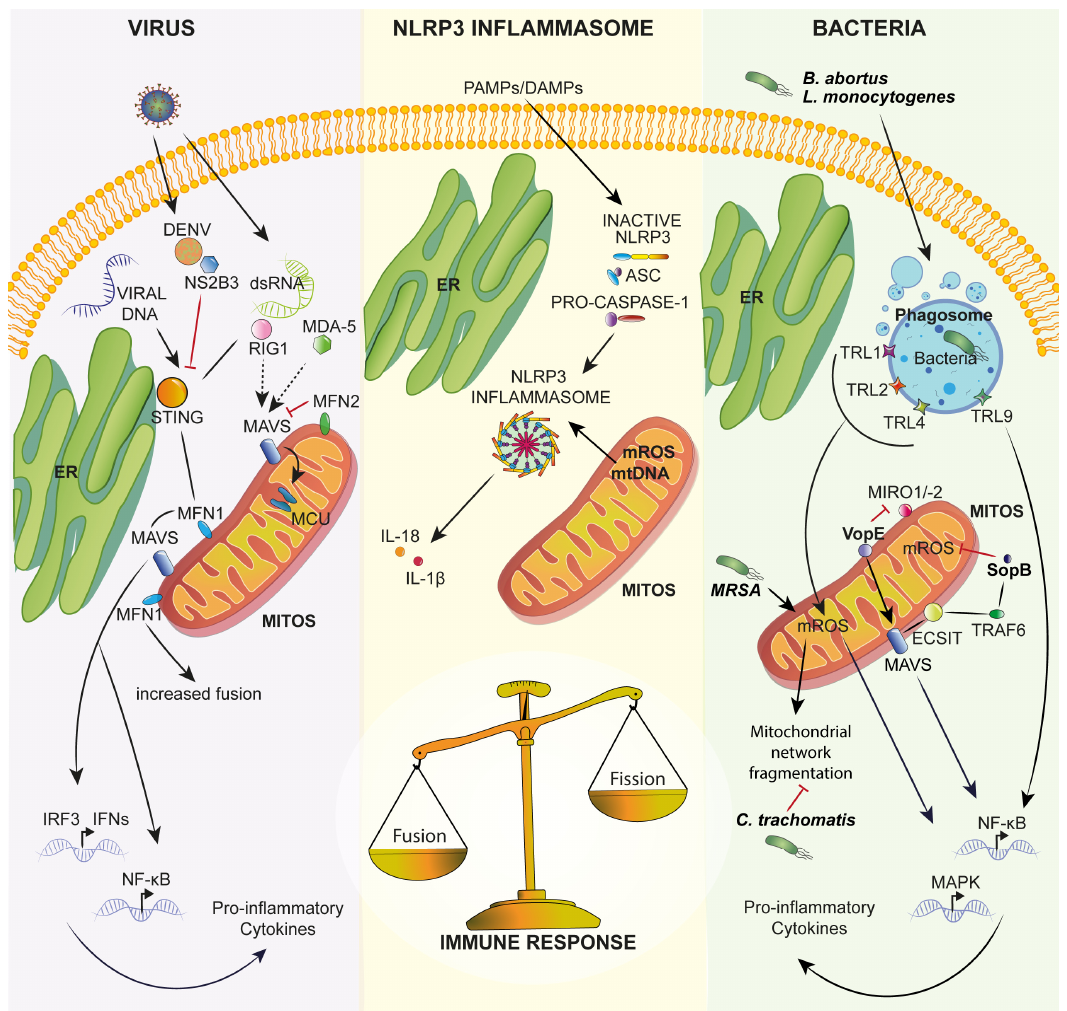
Figure 1. Schematic representation of the role of mitochondria in innate immunity. Viral infection, exposure to PAMPs/DAMPs or exposure to bacteria can activate the immune response, altering mitochondrial dynamics and functions. Upon viral infection, MAVS plays a key role in activation of the innate immune response, activating NF-kB and IRF-3 (interferon regulatory factor 3) signaling and inducing proinflammatory cytokine and type I interferon release. Moreover, mitochondria are a key source of DAMPs that are able to activate the NLRP3 inflammasome, leading to proinflammatory cytokine release such as IL-1 β and IL-18. Several bacteria manipulate mitochondria during infection. See text for further details. DAMPs: damage-associated molecular patterns; DENV: dengue virus; ER: endoplasmic reticulum; NLRP3: NOD-, LRR- and pyrin domain-containing 3; MCU: mitochondrial calcium uniporter; MDA-5: melanoma differentiation-associated gene 5; MFN: mitofusin; mROS: mitochondrial reactive oxygen species; PAMPs: pathogen-associated molecular patterns; RIG-1: retinoic acid-inducible gene I; TLRs: Toll-like receptors; TRAF6: tumor necrosis factor receptor associated factor 6.